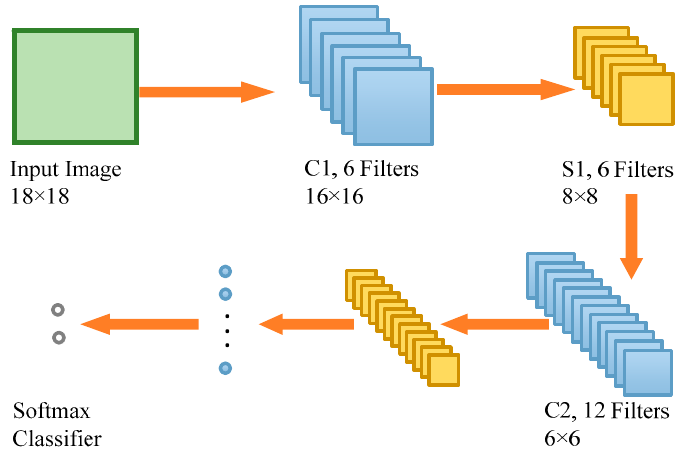
Figure 2. Architecture of CNN used in the proposed method.